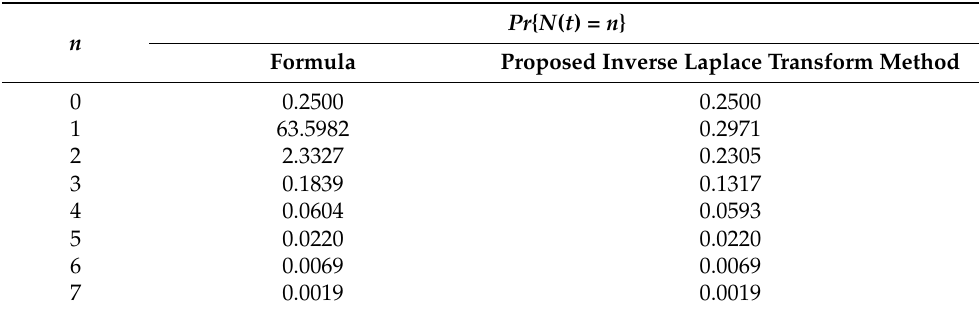
Table 3. Count probabilities for generalized Weibull count distribution when a = 2, α = 1 and λ = − 2 and t = 1.